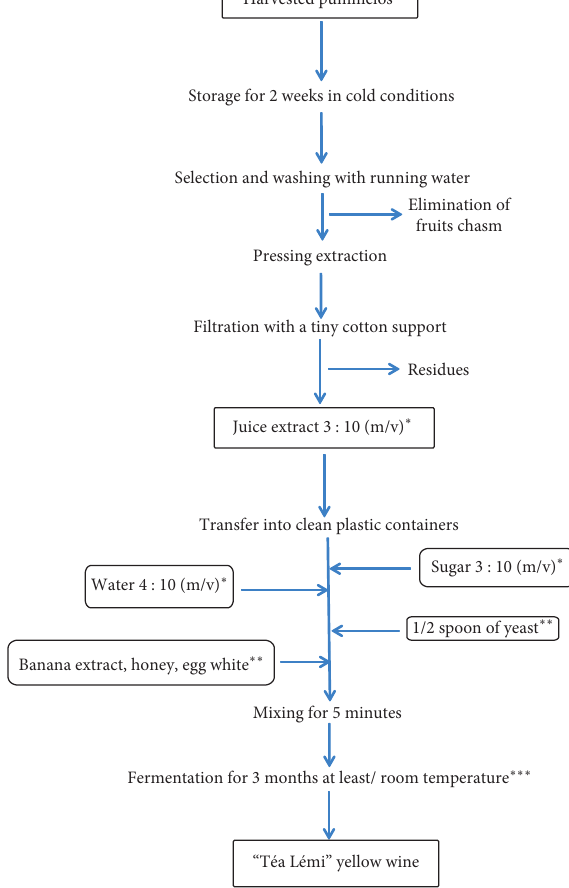
Figure 2: Flowchart of artisanal processing of yellow “T´ea L´emi” wine. ∗ Ratio applicable for 25L of beverage. ∗∗ Optional. ∗∗∗ Natural